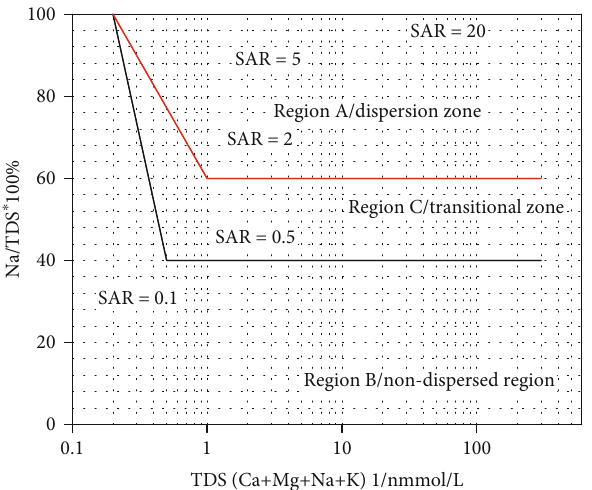
Figure 11: Relationships among the dispersion of soil and M pore water is calculated as follows: M Þ × 100 % .The sum of the contents of the four cations K + , Na + , Ca 2+ , and Mg 2+ is the TDS, which is measured in milligram M TDS equivalents per liter